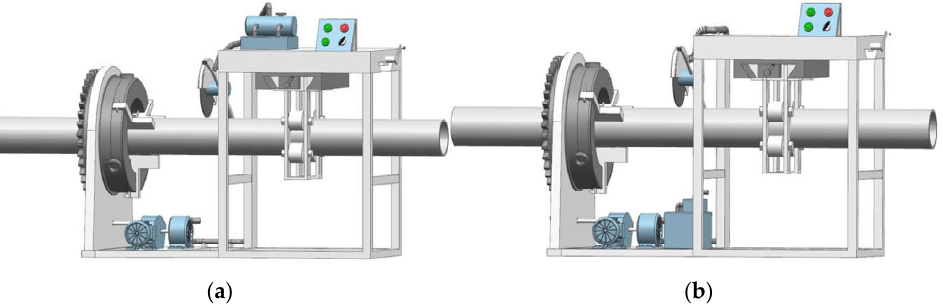
Figure 17. Summary solutions: ( a ) Summary solution 1; ( b ) summary solution 2.